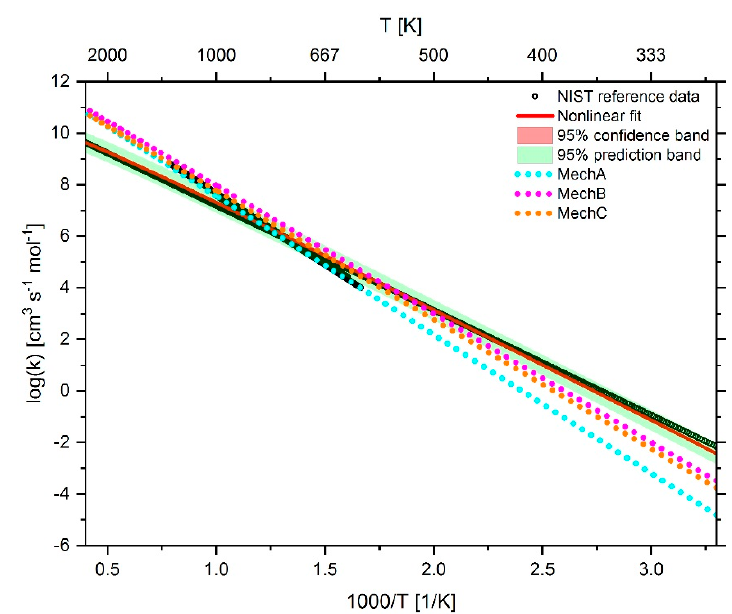
Figure 6. Comparison of the reaction rate coe ffi cient of reaction 45 (CH 4 + HO 2 ↔ CH 3 + H 2 O 2 ) of MechA to MechC as well as the fitted rate coe ffi cient using reference data from the NIST database.